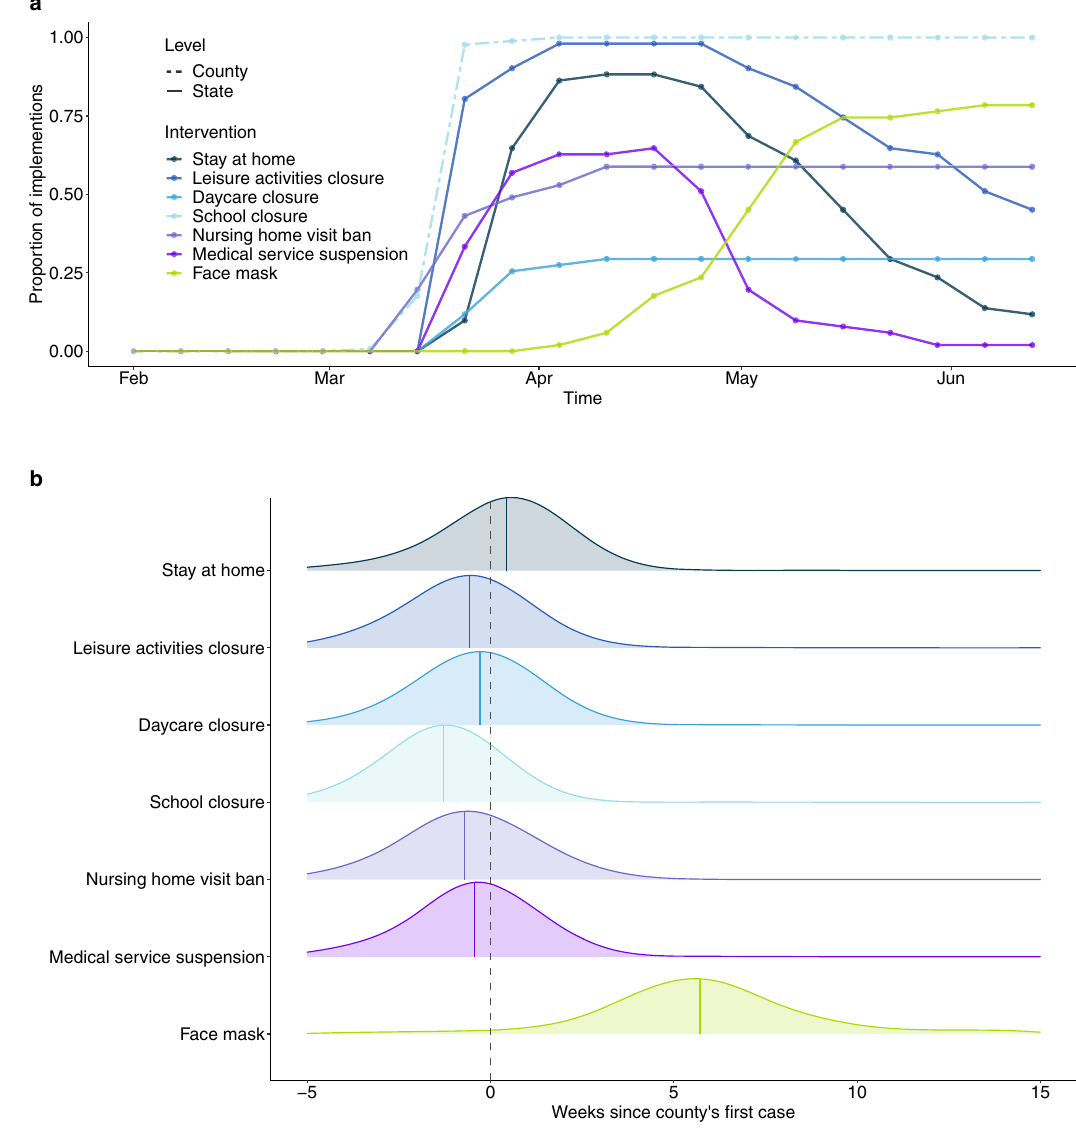
Fig. 2 Temporal distributions of non-pharmaceutical interventions. a Time series of the proportion of states and counties where interventions were implemented. The color denotes the non-pharmaceutical intervention at county- (dashed) or state- (solid) level. b Distribution of time differences between intervention times and the occurrence of the county ’ s fi rst con fi rmed case. Colored, solid lines indicate the median difference times of each intervention. Dashed vertical line indicates the week when the county reported its fi rst